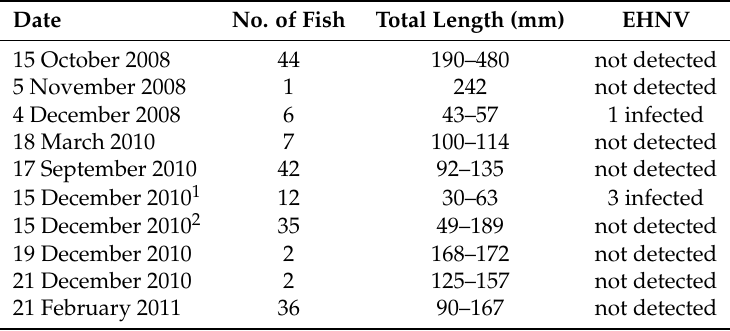
Table 2. Summary of results of virus-isolation tests for EHNV conducted on redfin perch tissue collected from Lake Ginninderra,